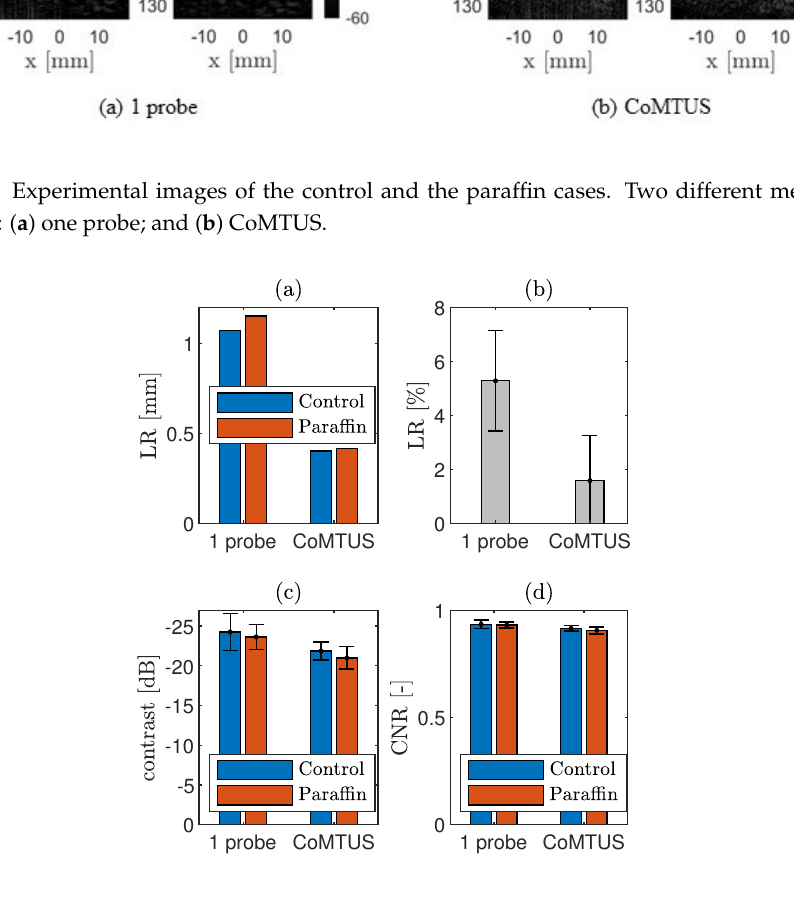
Figure 14. Computed quality metrics experimentally measured. ( a ) Lateral resolution (LR) measured at an 85 mm depth; ( b ) changes in LR measured in the four point targets when imaging through the paraffin and relative to the control case; ( c ) contrast; and ( d ) contrast-to-noise-ratio (CNR). Two different methods are compared: one probe and